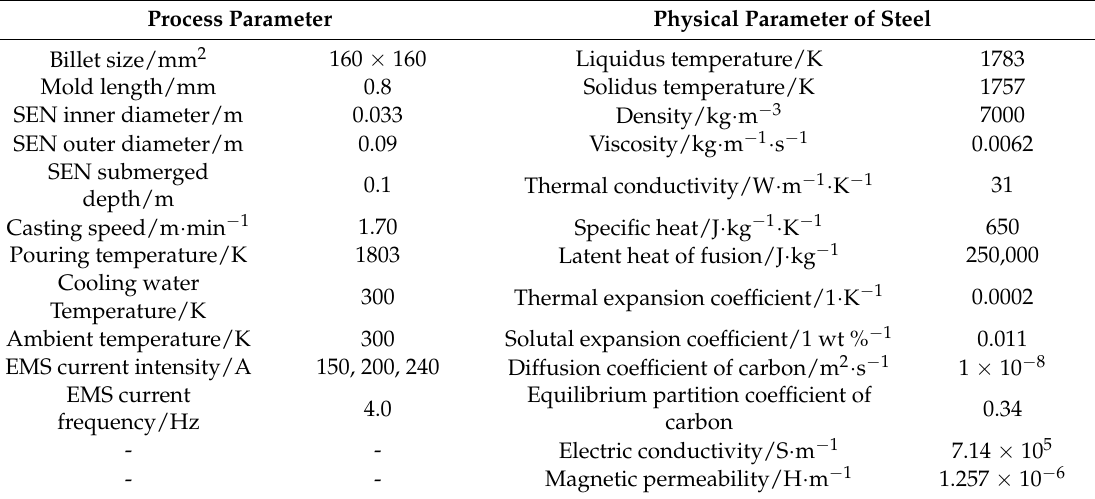
Table 2. The process parameters and physical properties of steel.